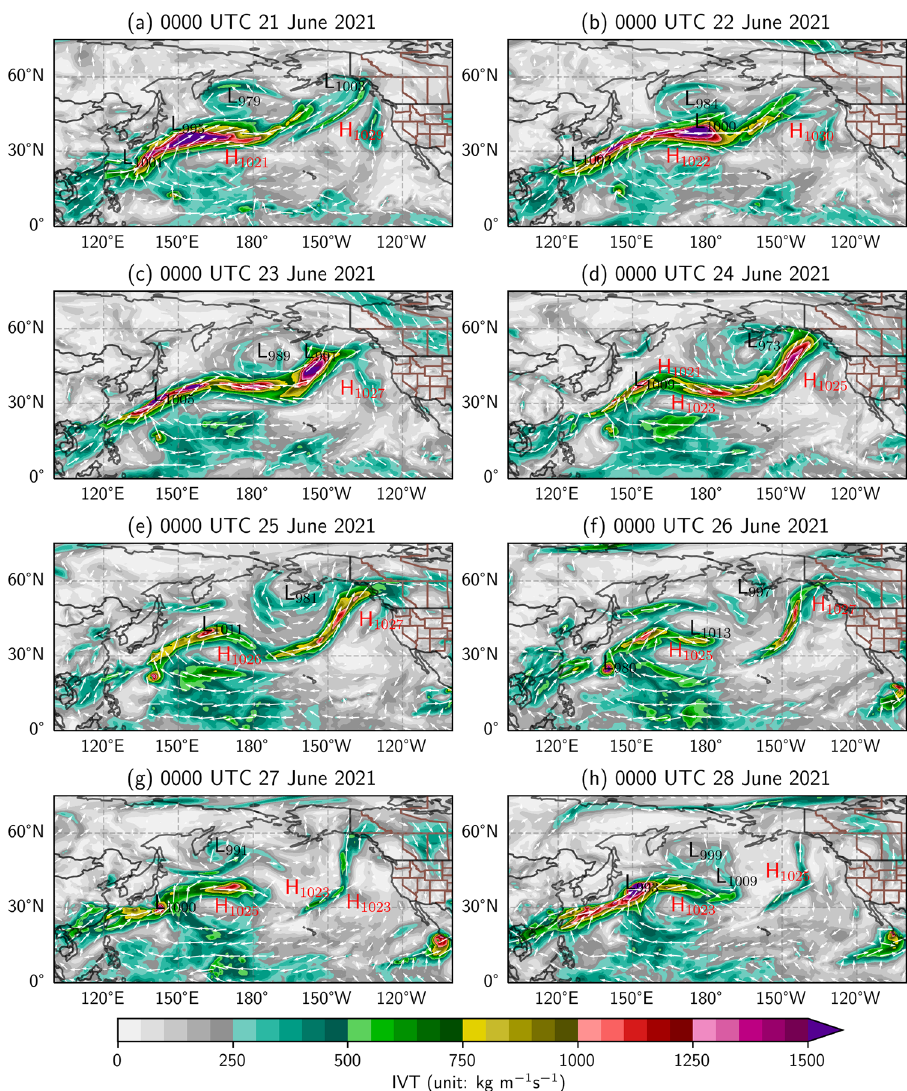
Fig. 2 The development of an oriental express across the North Paci fi c. a – h The snapshots of IVT distributions valid at 0000 UTC during 21 – 28 June 2021. Data are from the ERA5 reanalysis. The vector represents the integrated water vapour fl ux ð Q u ; Q v Þ de fi ned in “ Methods ” . IVT ¼ ð Q 2 u þ Q 2 v Þ 1 major high and low centres of SLP in the Paci fi c Ocean are marked by letters “ H ” and “ L ” with their local maximum/minimum SLP values (in